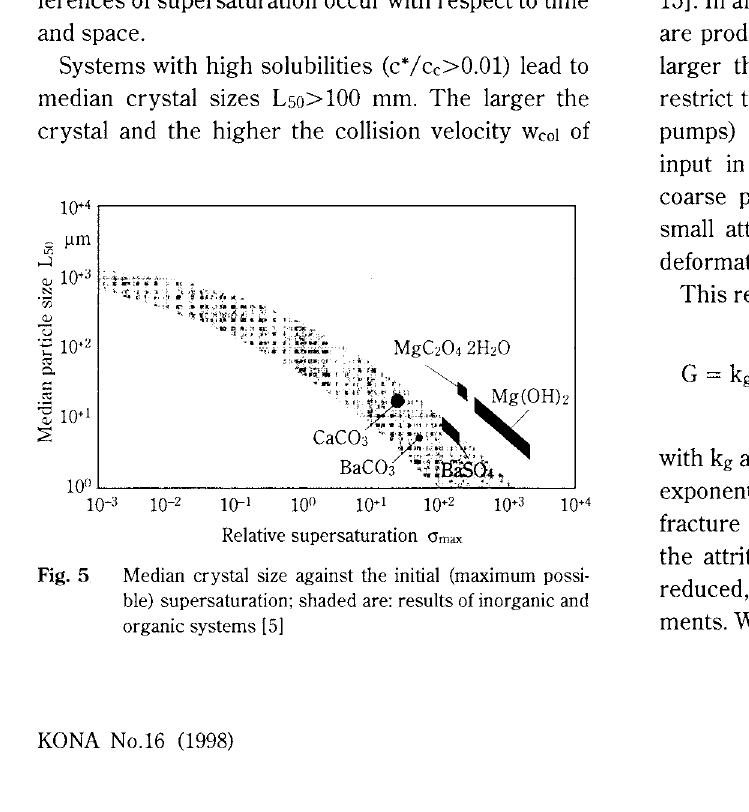
KONA No.16 (1998)